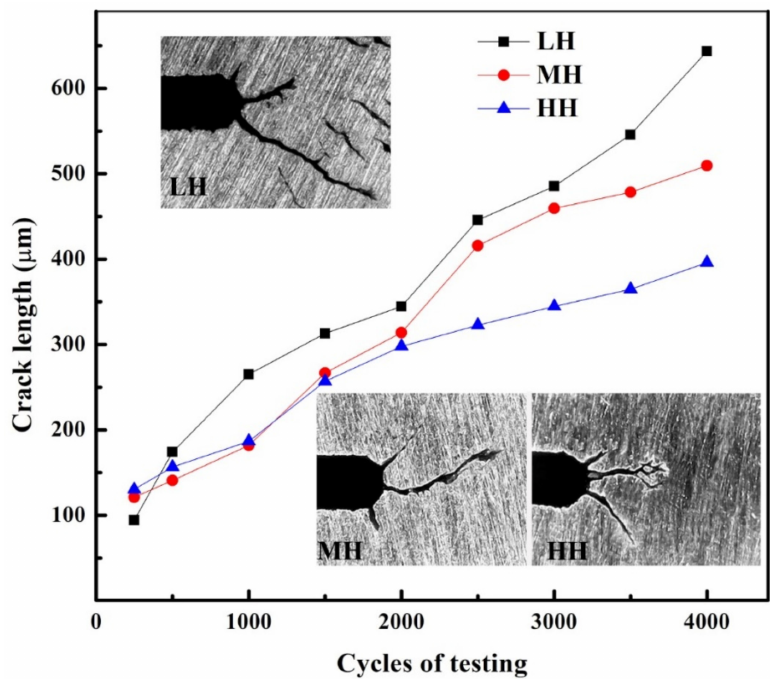
Figure 8. Crack propagation curves and crack images of the SLM-processed LH, MH, and HH during TF